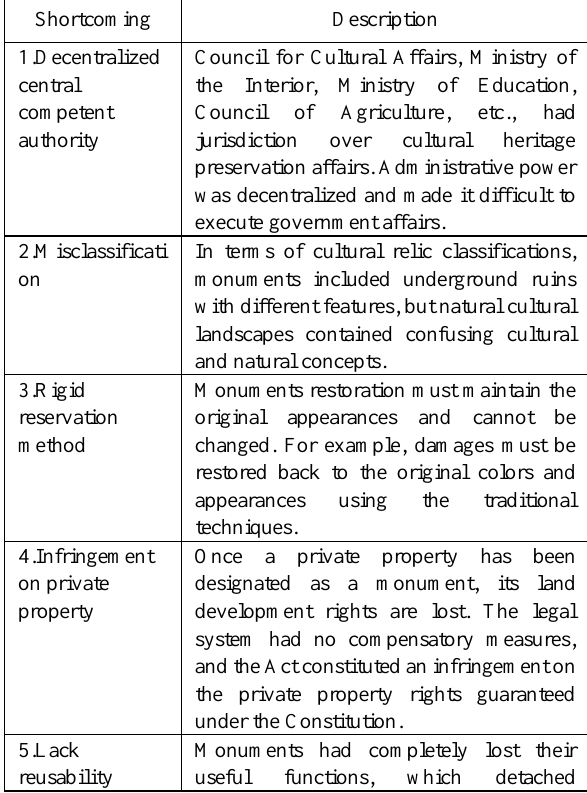
Table 1. Structural shortcomings for the first edition of the